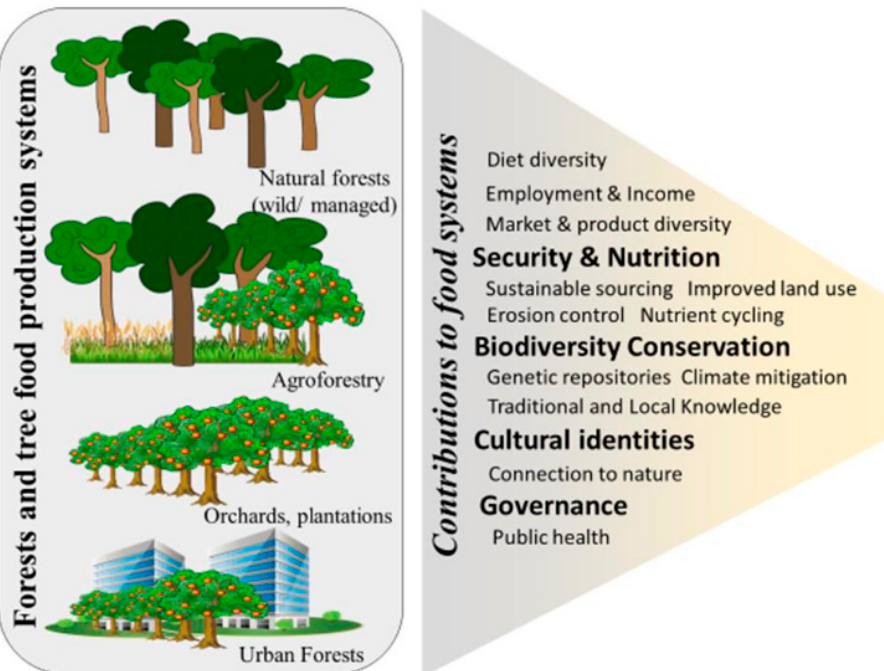
Figure 1. Contributions of forest and trees to food systems.